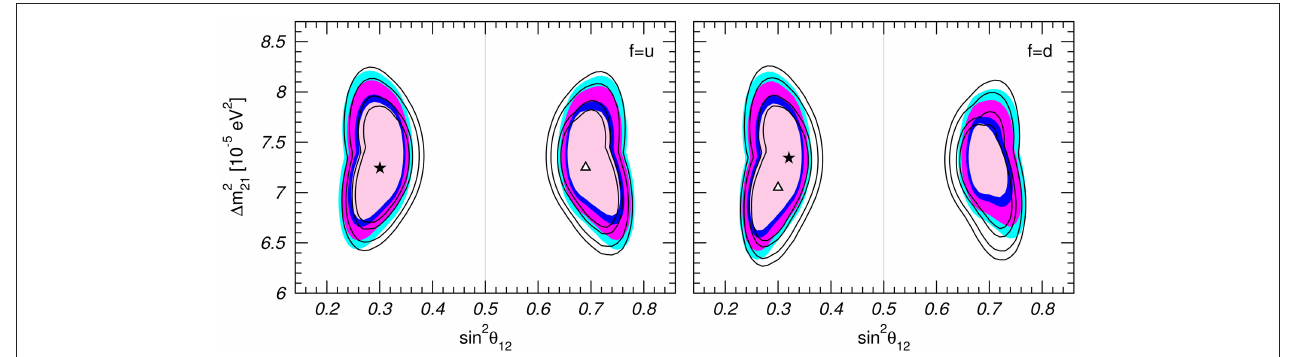
FIGURE 5 | Allowed regions at 90, 95, 99% and 3 σ C.L. (2 d.o.f.) from the analysis of solar and KamLAND data in the presence of NSI with up (Left) and down (Right) quarks. The colored filled and contour regions in each panel correspond to different analysis of solar SNO data. Star and triangle denote the corresponding best fits. This figure has been taken from Gonzalez-Garcia and Maltoni [11], published under the terms of the Creative Commons Attribution Noncommercial License and therefore no copyright permissions were required for its inclusion in this manuscript. See this reference for further details.